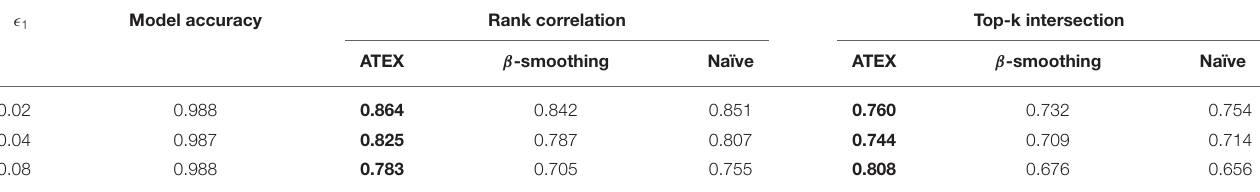
TABLE 3 | Defense against untargeted explanation manipulation on MNIST. ǫ 1